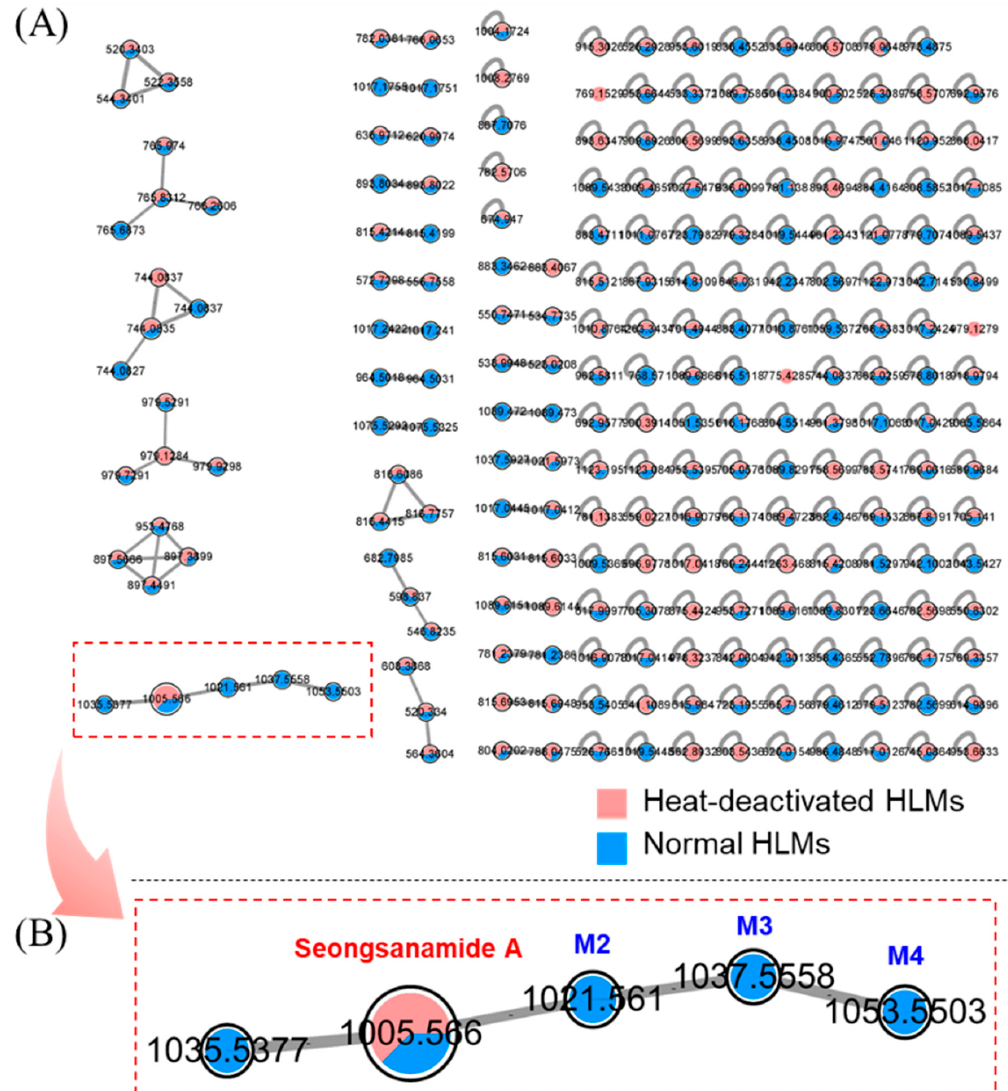
Figure 3. Visualization of in vitro seongsanamide A metabolism using feature-based molecular networking. Seongsanamide A was incubated with human liver microsomes (HLMs). ( A ) The overall multi-matrix molecular network. ( B ) Details of the specific seongsanamide A containing cluster. Nodes are labeled with the m/z value and identified metabolite name (M2, mono-hydroxyseongsanamide A; M3, di-hydroxyseongsanamide A; and M4, tri-hydroxyseongsanamide A). Red nodes represent the ions from the heat-deactivated HLMs, and blue nodes represent the ions from the normal HLMs.